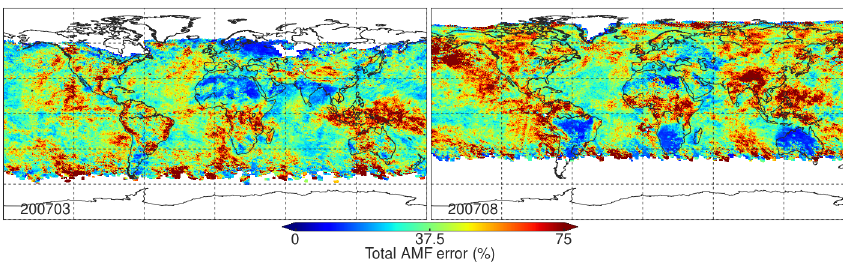
Figure 9. Monthly mean GOME-2 total AMF errors for March (left) and August (right) 2007 calculated using Eq. (7). The AMF errors are gridded on to a 0.25 ◦ × 0.25 ◦ grid using observations with cloud fractions <